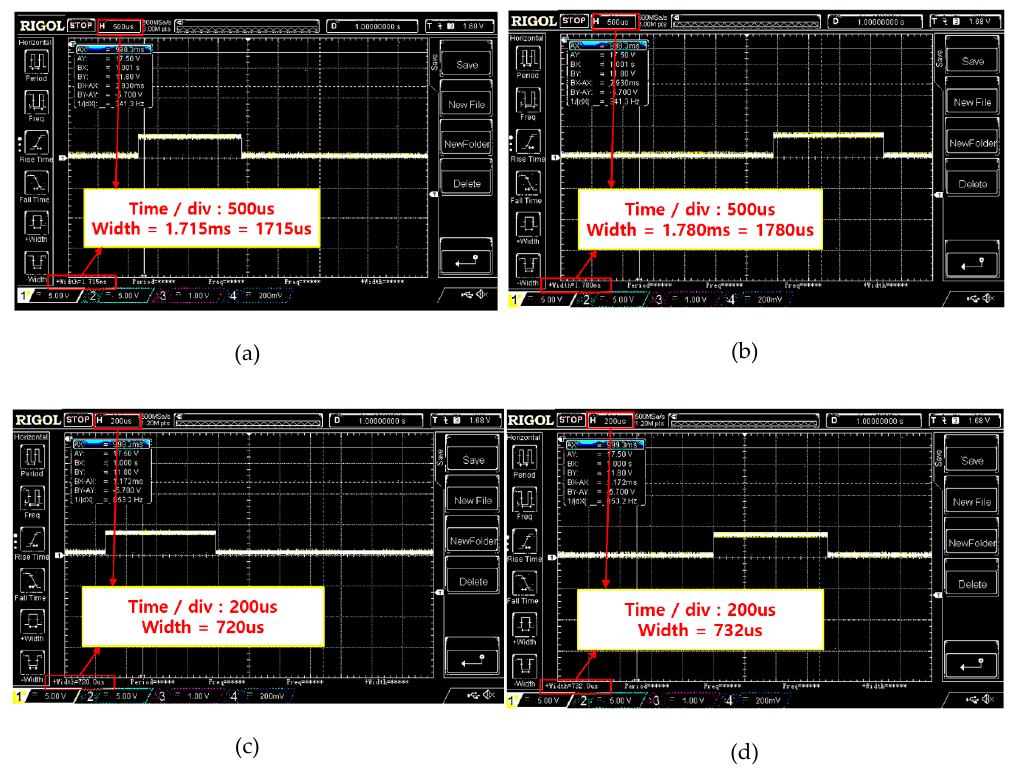
Figure 5. The infrared sensor signal measured with the oscilloscope. ( a ) Infrared sensor output of M1; ( b ) infrared sensor output of M2; ( c ) infrared sensor output of M3; ( d ) infrared sensor output of M4.